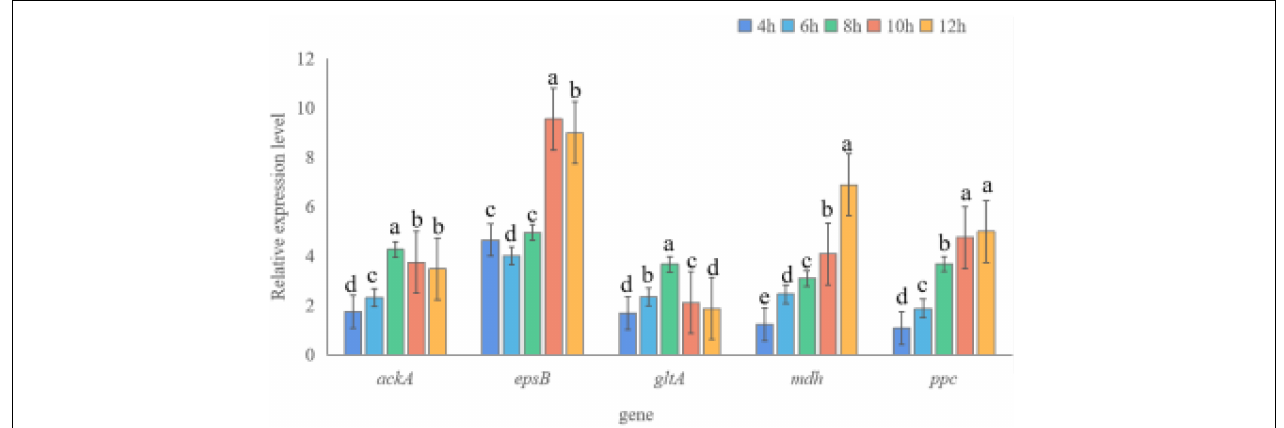
FIGURE 2 | Expression levels of potassium solubilization genes in B. aryabhattai SK1-7. Different letters above the bars indicate significant differences ( p < 0.05). The error bars indicate standard errors ( n =